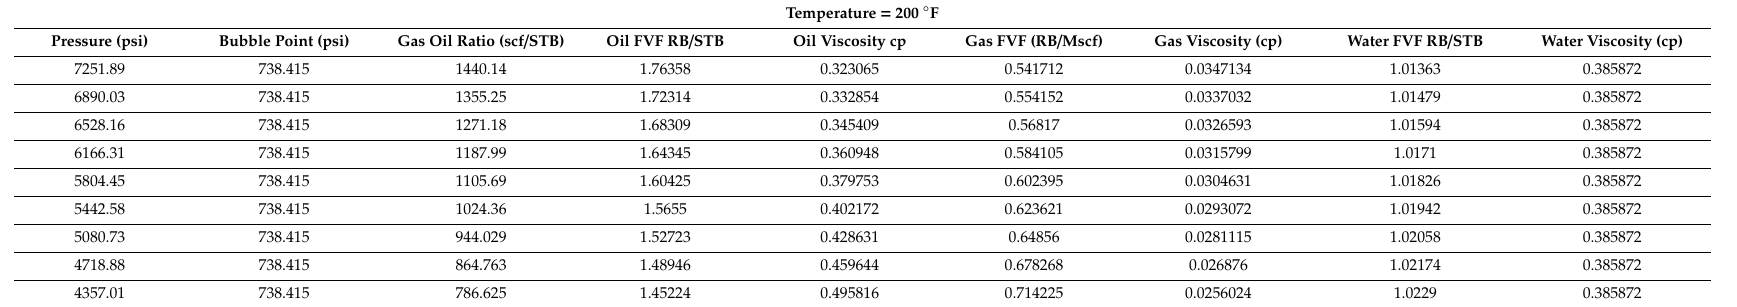
Table A2. PVT properties at 200 ◦ F.